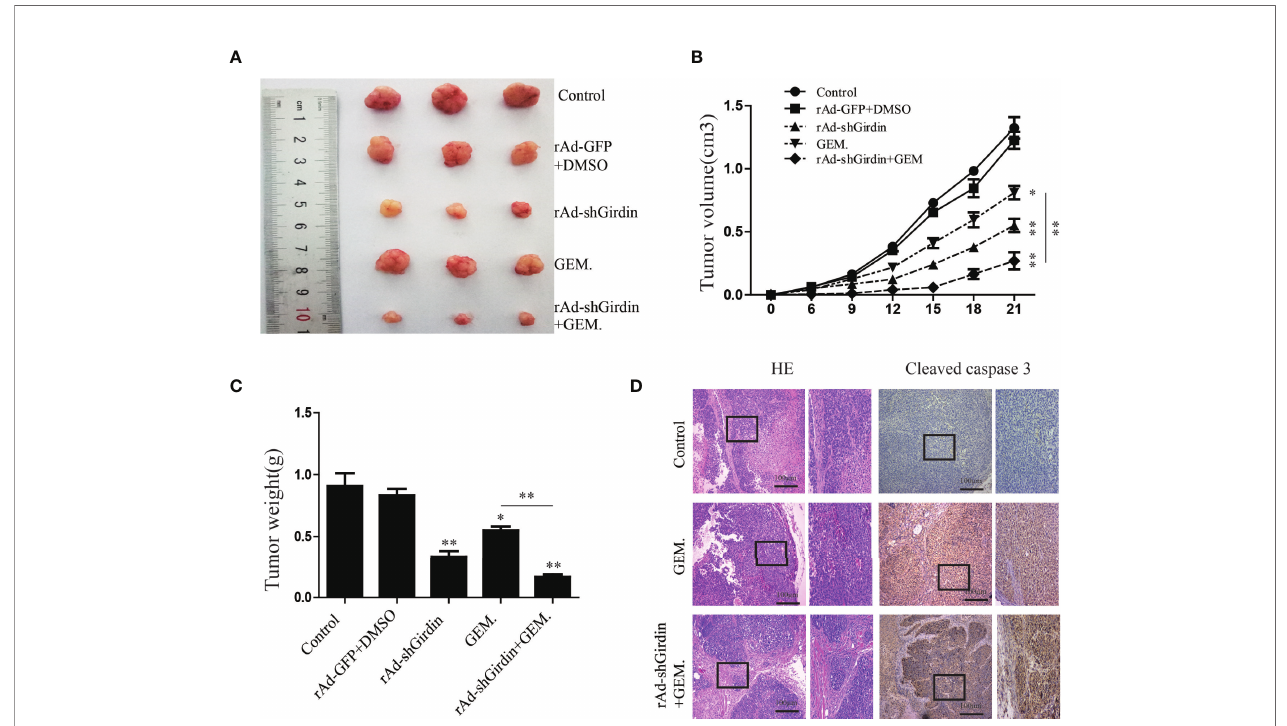
FIGURE 8 | Girdin down-regulating suppresses pancreatic cancer growth and enhances gemcitabine chemosensitivity in a xenograft model. (A) Representative data from xenograft tumors in mice in the different groups. (B, C) Statistical analysis of tumour volumes and weights in the different groups (n = 4). (D) Images of immunohistochemical staining using antibodies against cleaved caspase-3.